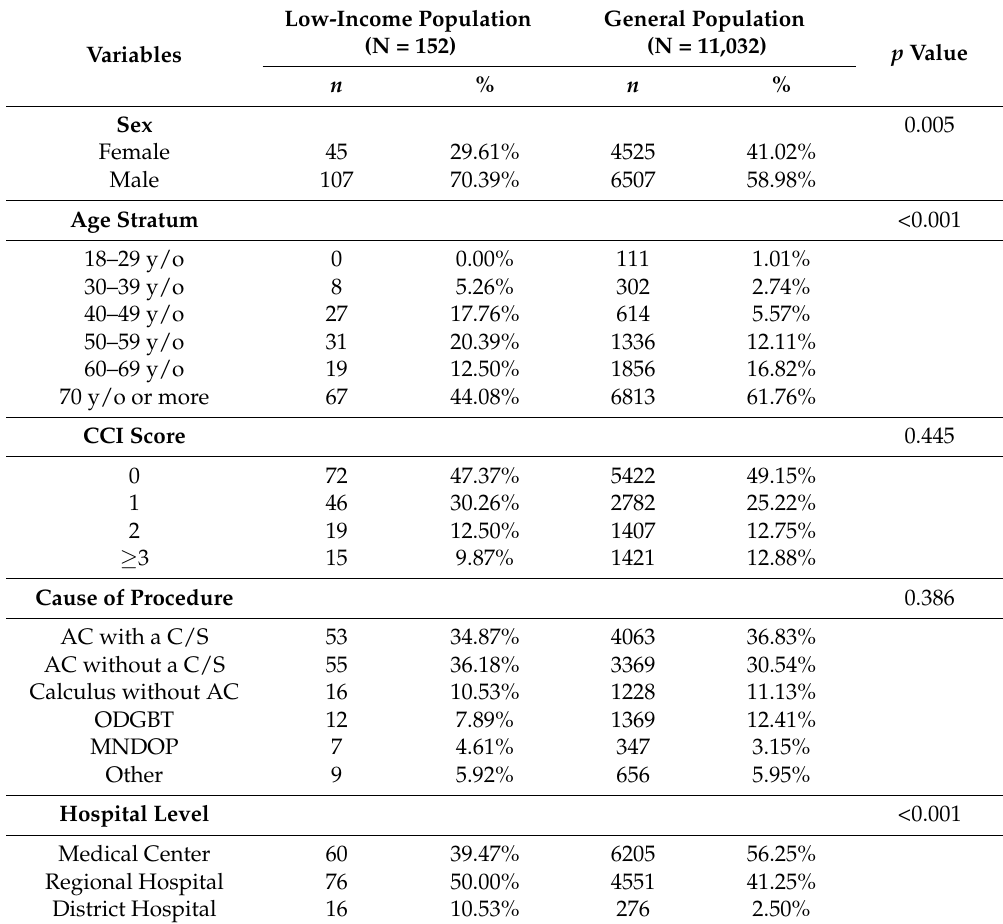
Table 1. Demographic characteristics of patients undergoing percutaneous cholecystostomy in Taiwan from 2003 to